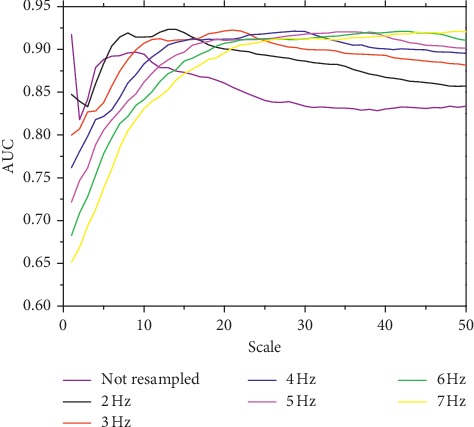
AUC of AC obtained from clinical data at different scales with and without preprocessing.